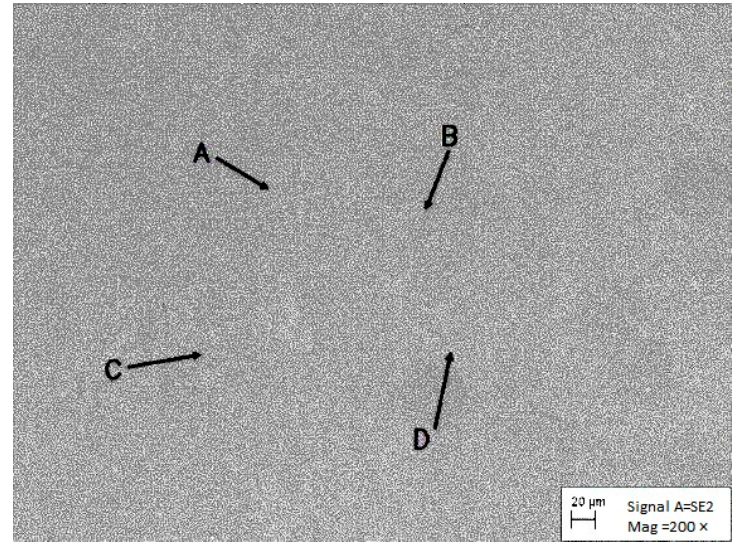
Figure 8. Cross-section morphology of surfacing layer (200 times).